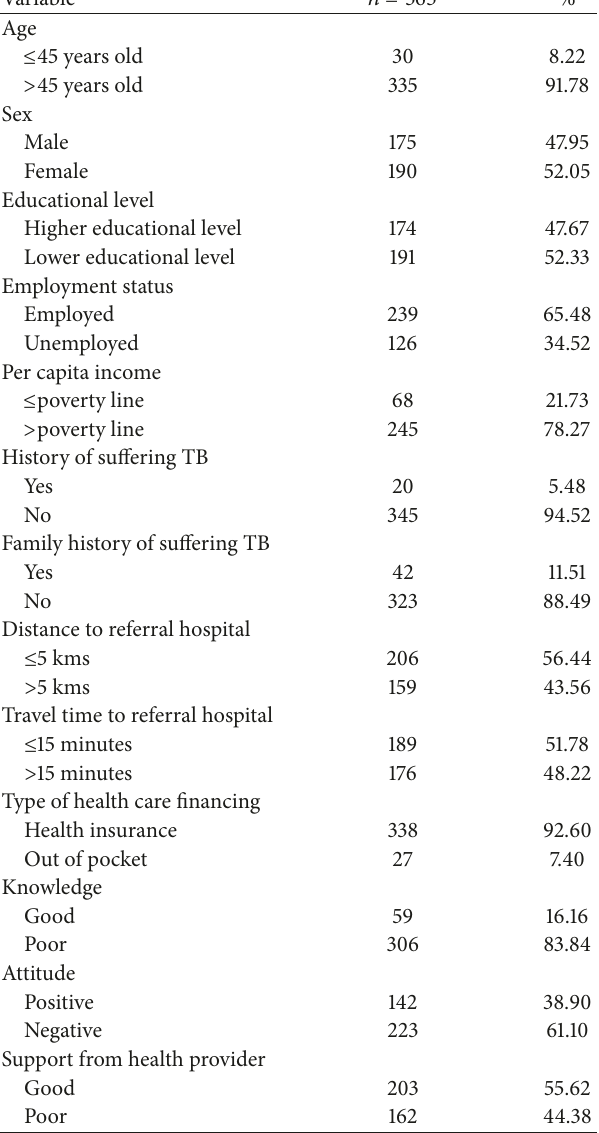
Table 1: Sociodemographic characteristics, access, knowledge, atti- tude, and support from health provider, Denpasar, January–March